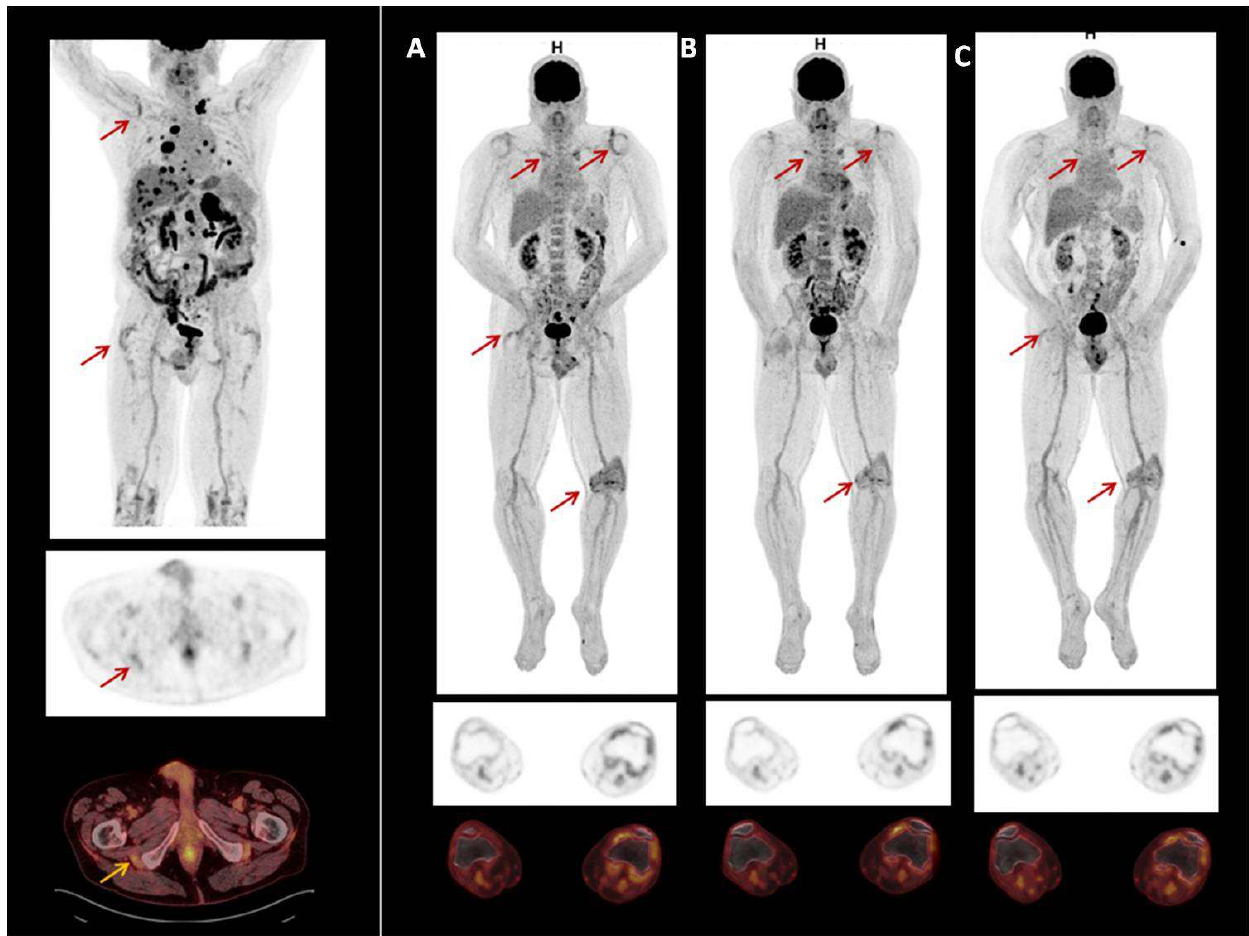
Figure 6. 18 F-FDG PET/CT image of patient with prostate carcinoma treated with Atezolizumab and Cabozatinib. Symmetric FDG uptake shoulder, hip joints, greater trochanter and ischial tuberosities. Also show, FDG uptake in left knee ( A ). In 2020, due to irAEs ICI were discontinued. After discontinuation of treatment, uptake decreased ( B , C ).